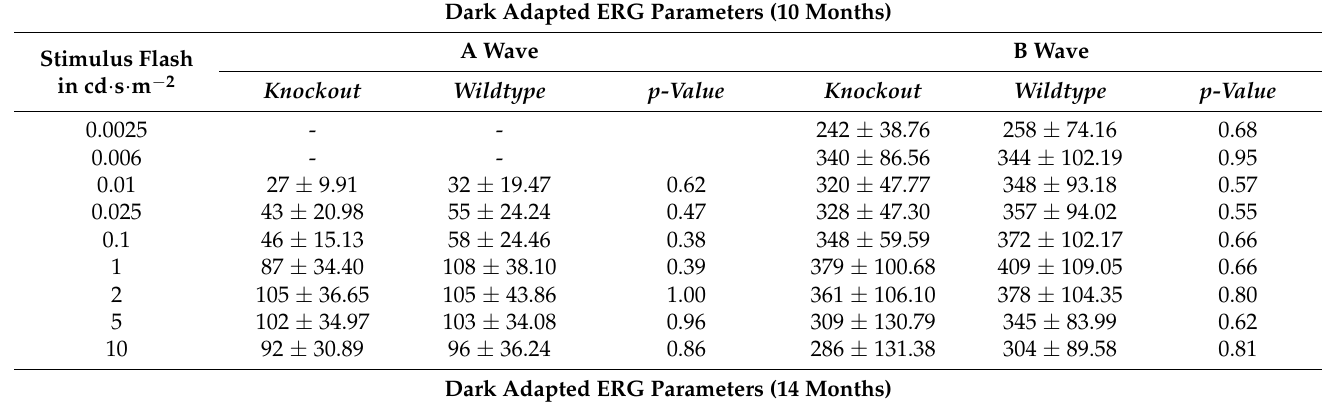
Table 1. ERG Parameters in Epm2a knockout and wildtype mice. Dark Adapted ERG Parameters (10